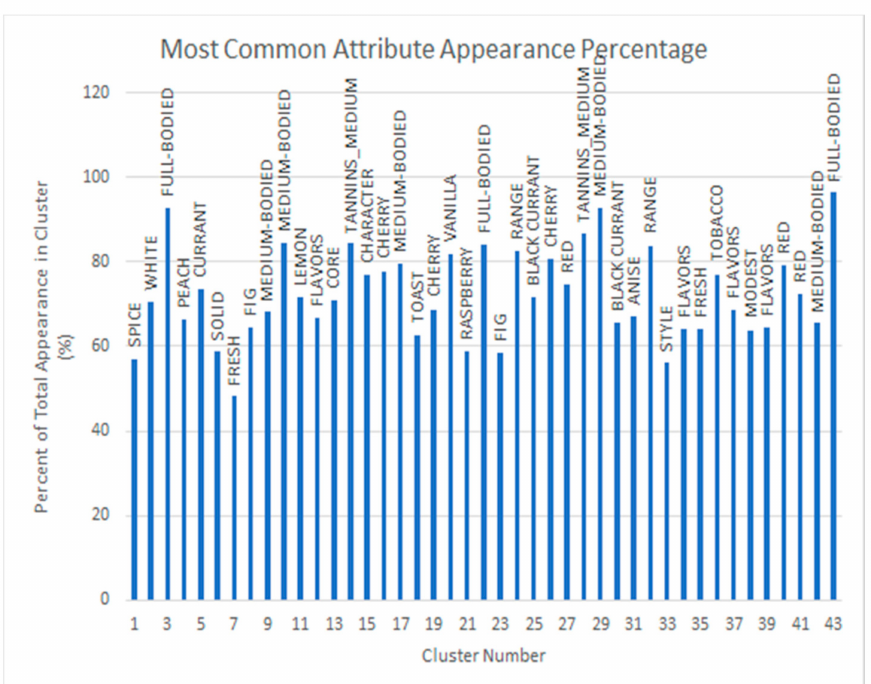
Figure 8. Most common attributes per cluster at optimum cluster number (K = 43). The most common attribute of each cluster, or group, of wines is shown as a percentage of appearance in each cluster overall. Labels above the bars correlate to the percentage of appearance of that attribute in the cluster. These characteristics are typically the primary characteristics for grouping the wines.